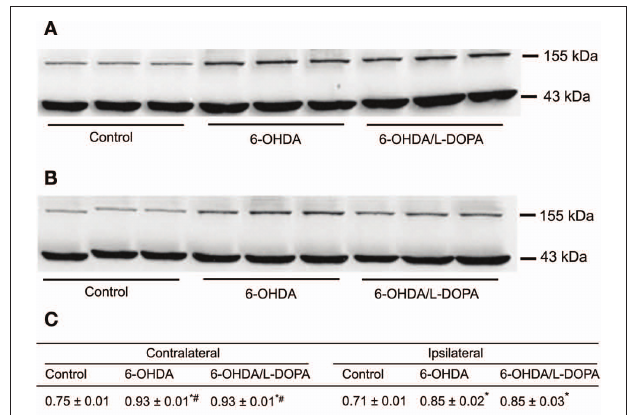
Figure 4 | Western blot analysis of nNOS protein in the rat striatum: effect of lesion and l -DOPA chronic treatment in control, 6-OHDA-lesioned and on established l -DOPA-induced AiMs. Treatment is described in Methods. (A) Contralateral and, (B) ipsilateral striatum. Lines indicate specific bands at ∼ 155 kDa (nNOS) and ∼ 43 kDa of a loading control ( β -actin). (C) There was an increment of nNOS protein expression in both ipsilateral and contrataleral striatum for 6-OHDA-lesioned and l -DOPA-treated-6-OHDA-lesioned rats. The values obtained from contralateral side were higher than the ipsilateral one. * p < 0.05 vs control;